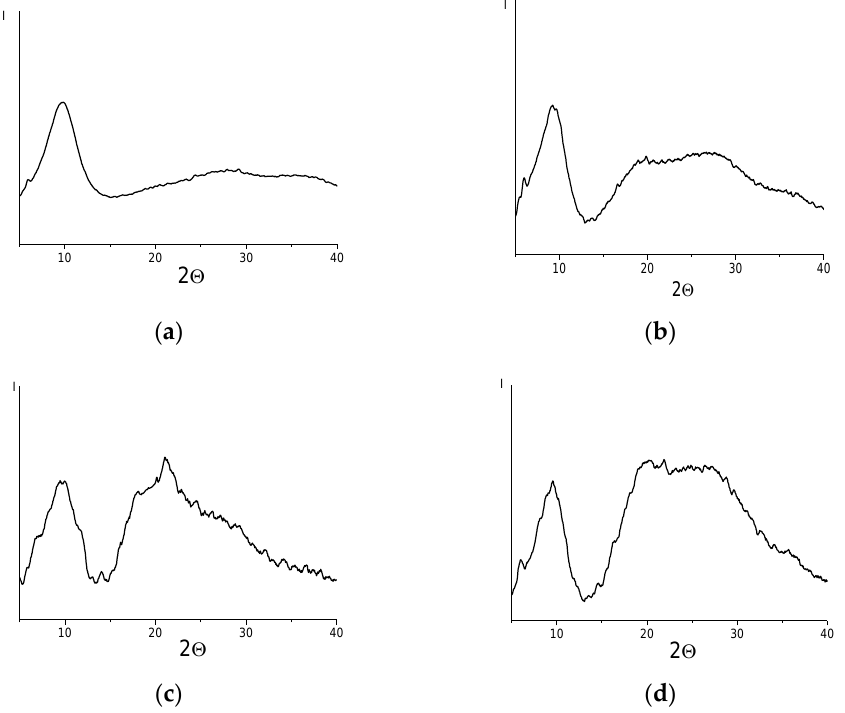
Figure 3. The diffraction curves of PTMSP ( a ), Br-containing PTMSP ( b ), polymer containing 5 mol% ( c ) and 20 mol% ( d ) butylimidazole salt.